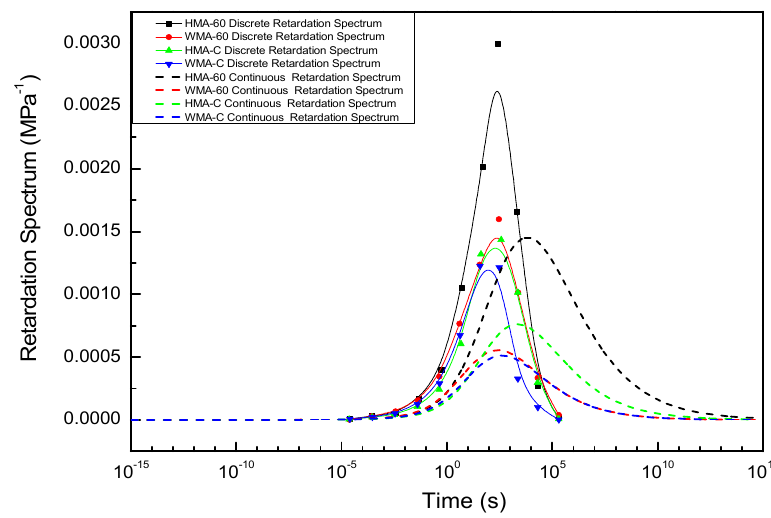
Figure 8. The discrete and continuous retardation spectrum of asphalt mixture.